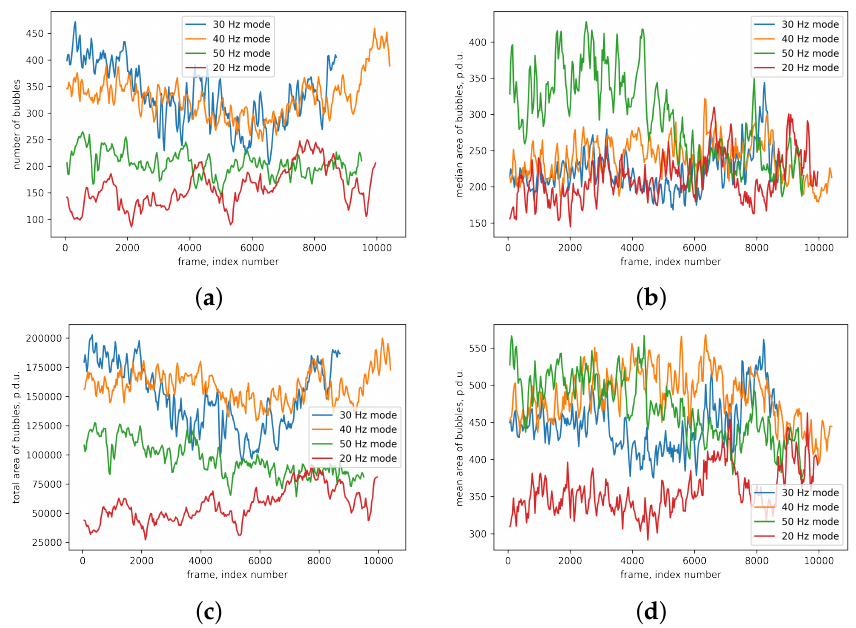
Figure 22. Rolling means of three frames of number ( a ), median area ( b ), total area ( c ) and mean area ( d ) of bubbles for 20 Hz (red), 30 Hz (blue), 40 Hz (orange) and 50 Hz (green). As seen the number (quantity) ( a ) and the total area ( c ) are highly correlated. The median ( b ) and mean areas ( d ) look alike for all modes. Therefore various distribution characteristics have different resolutions in terms of bioreactor